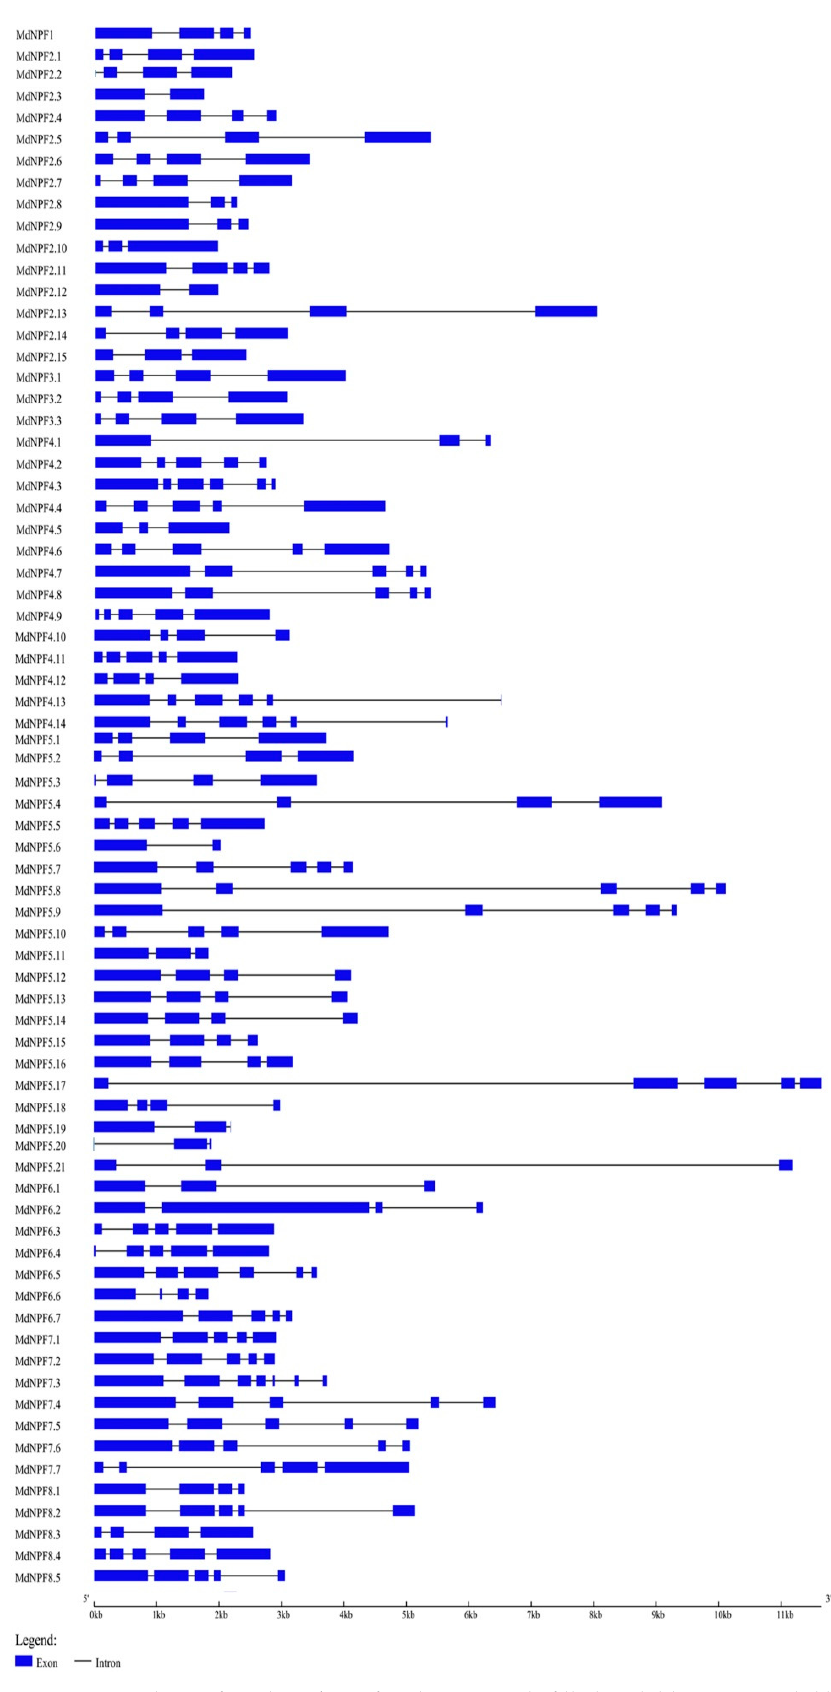
Figure 4. Structure analysis of apple MdNPF family. Rectangle filled with blue, exon; solid black line, intron. Scale at bottom is in kb.